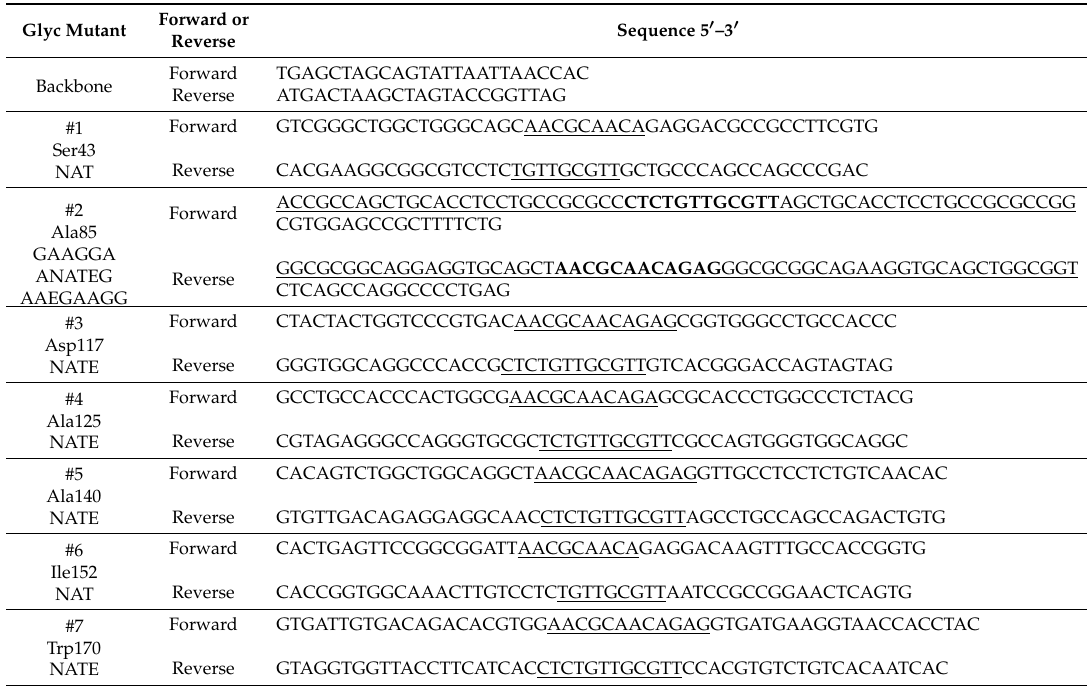
Table 1. Primer sequences for glycosylation